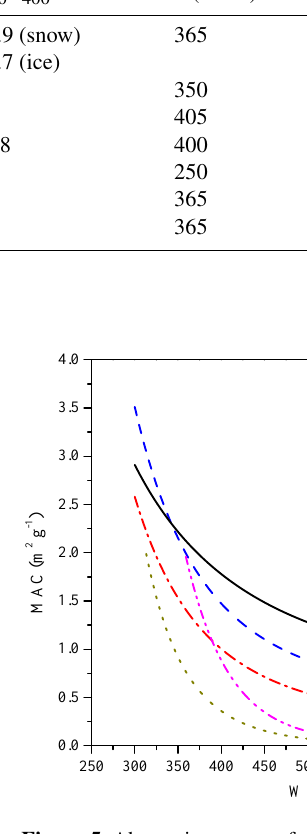
Figure 5. Absorption spectra for DOC in snow and ice of LHG and the dust from surrounding